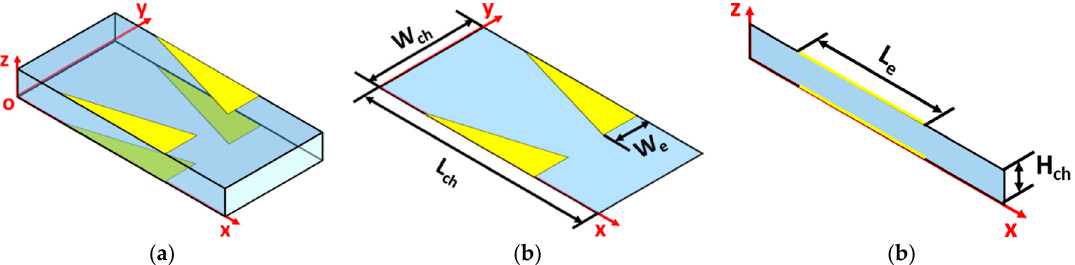
Figure 1. Variation of Re [ f CM ] with frequency for ( a ) polystyrene and ( b ) silica microparticles.